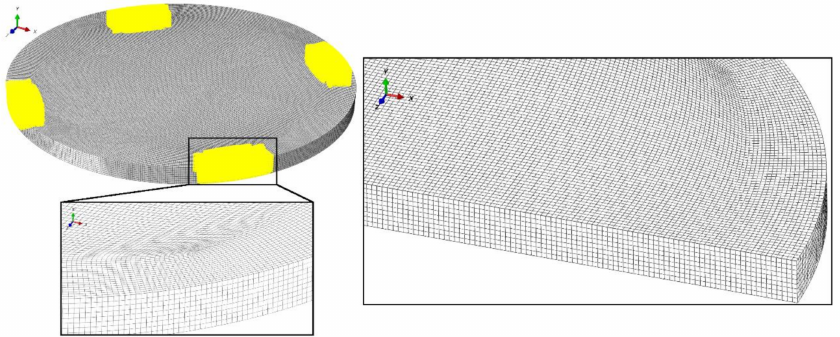
Figure 11. Finite element mesh of the 3D model with highlighted (yellow) elements with an aspect ratio greater than